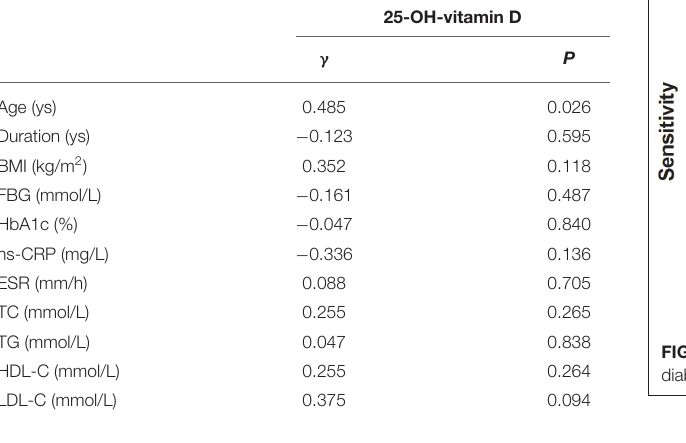
25-OH-vitamin D